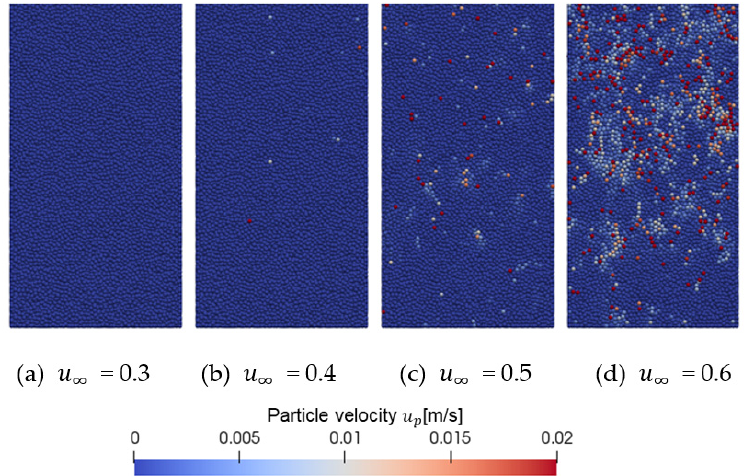
Figure 7. Incipient motion of particles. The upper side and lower side indicate x/D = 2.125 and x/D = 4, respectively. ( a ) u ∞ = 0.3 m/s; ( b ) u ∞ = 0.4 m/s; ( c ) u ∞ = 0.5 m/s; ( d ) u ∞ = 0.6 m/s.